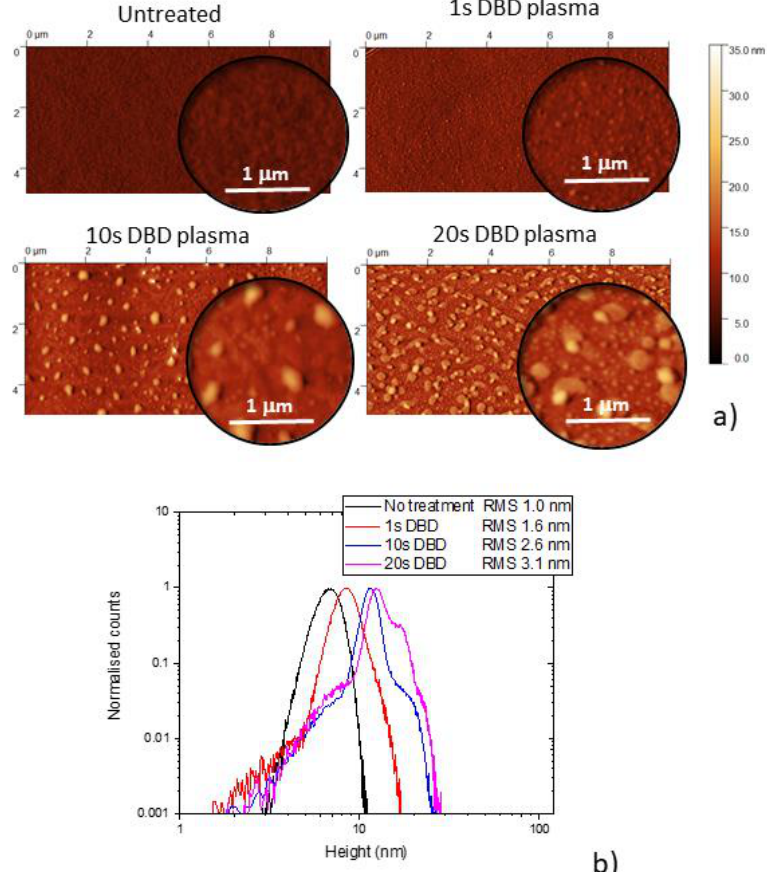
Figure 3. (a) Atomic force microscopy (AFM) images of untreated and DBD-treated Kapton and ( b ) corresponding height histograms. ( b ) corresponding height